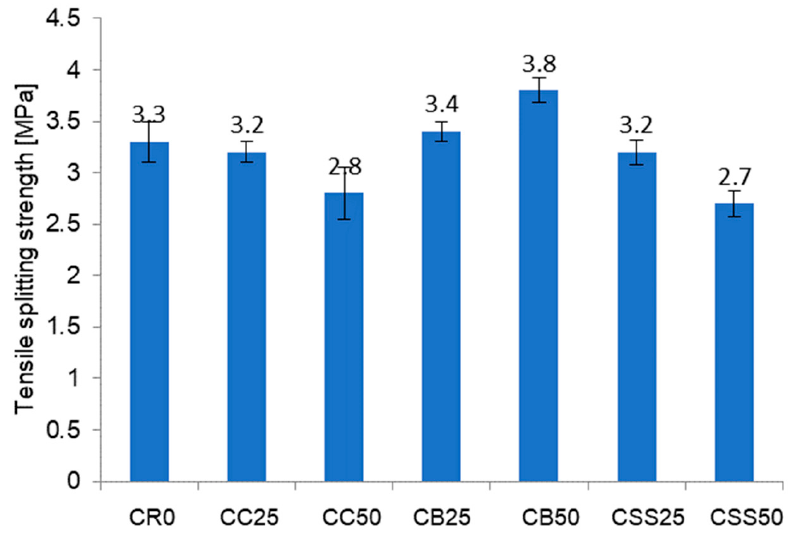
Figure 10. Test results of concrete tensile splitting strength after 28 days of